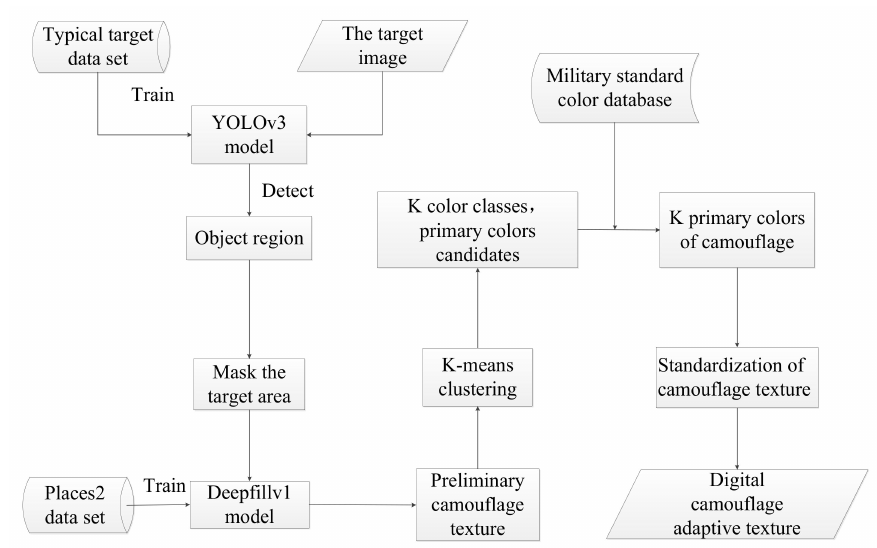
Figure 1. Outline of proposed digital camouflage design method.